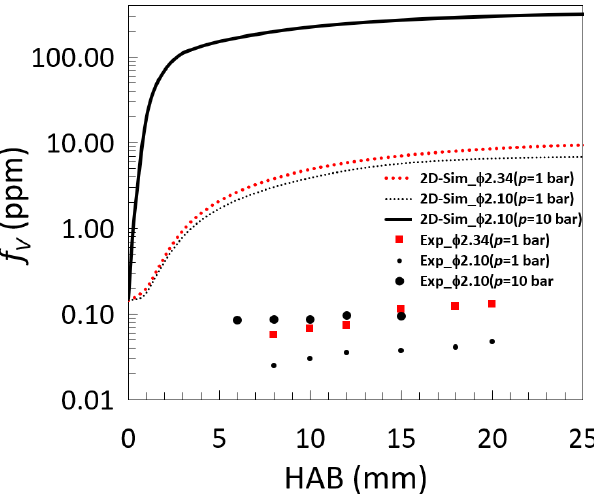
Figure 8. Comparison between the measured centerline f V (ppm) profiles [6] (symbols) and the 2D simulated ones (lines) of C 2 H 4 /air flames at p = 1.01 (dotted lines) and 10 (solid line) bar for ϕ = 2.1 (in black) and at p = 1.01 bar for ϕ = 2.34 (in red).